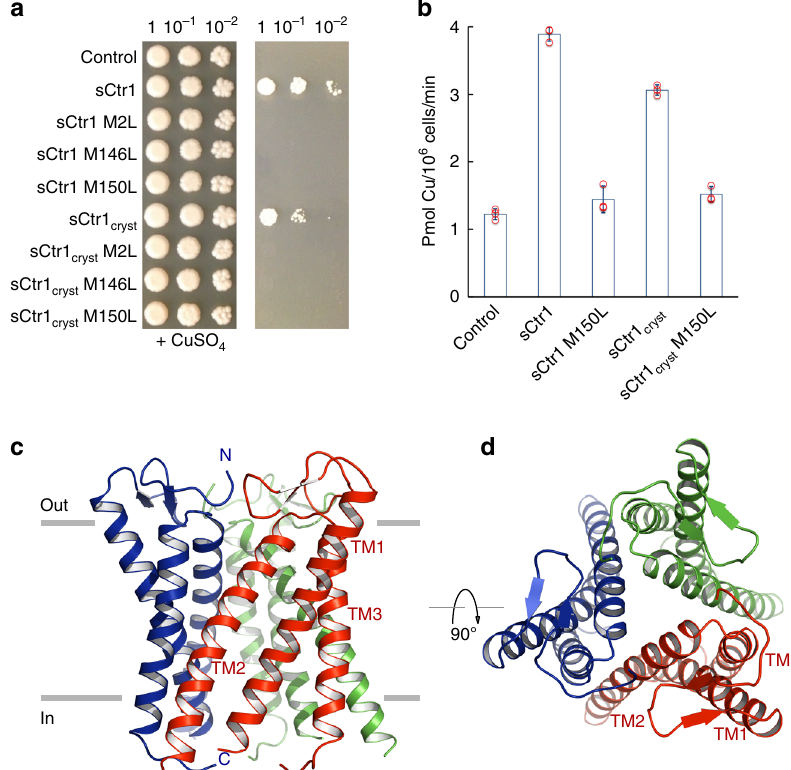
Fig. 1 Structure and function of sCtr1. a Functional complementation of sCtr1 constructs including the full-length wild-type sCtr1 and inactive mutants sCtr1 M146L, sCtr1 M150L, and sCtr1 M2L (M146L/M150L double mutant) and the corresponding constructs in the sCtr1 cryst background. Empty vector is the negative control. Growth on YPEG plates without the supplement of Cu (right panel) requires a functional Cu transporter expressed in the S. cerevisiae strain MPY17. Cells were plated as drops with 10-fold serial dilutions. Experimental detail is described in Methods. b 64 Cu uptake by the S. cerevisiae strain MPY17 expressing sCtr1 and sCtr1 cryst constructs. Values are mean ± s.d. and data were collected from three independent measurements. Source data are provided as a Source Data fi le. c Side view of the symmetric sCtr1 trimer, with each subunit uniquely colored. Gray lines indicate the approximate membrane boundary demarcating outside and inside of the plasma membrane. The N- and C- termini and transmembrane helices are labeled. d Top view from the extracellular